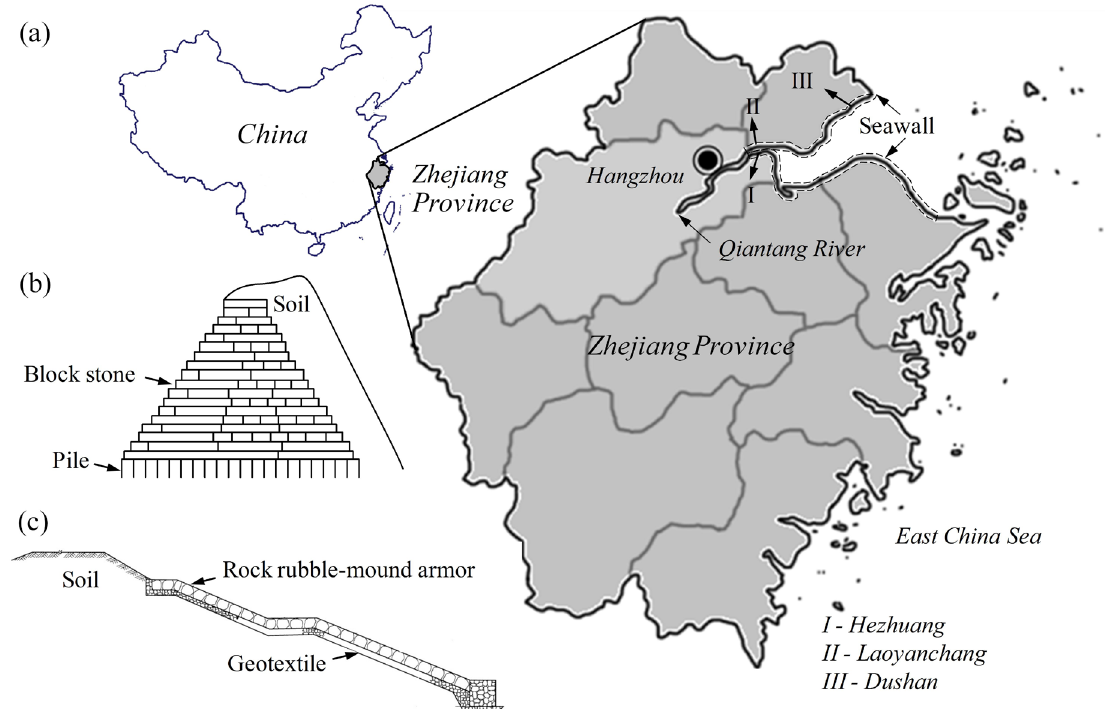
Fig 1. Study site. (a) Location of the Qiantang River in China; (b) Stone seawall; (c) Slope